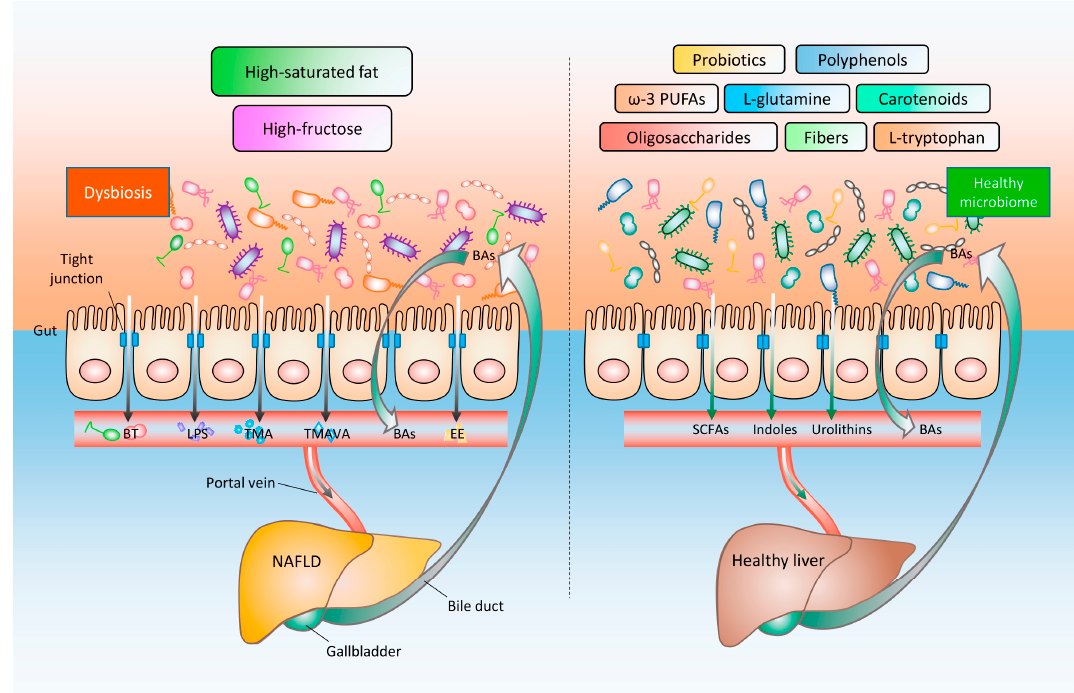
Figure 1. Non-alcoholic fatty liver disease (NAFLD) induced by unbalanced diet and its nutritional improvement strategies based on the gut–liver axis. Long-term high-saturated fat or high-fructose diet leads to an imbalanced intestinal flora, which in turn elicits an impaired gut barrier function and increased permeability, followed by bacterial translocation (BT), and additional bacterial components and metabolites (e.g., lipopolysaccharides (LPS), trimethylamine (TMA), N,N,N-trimethyl-5-aminovaleric acid (TMAVA), and endogenous ethanol (EE)) entering into the liver through the portal vein. NAFLD patients exhibit abnormal bile acids (BAs) metabolism and its related signaling pathways. These factors together accelerate the occurrence and progression of NAFLD. By contrast, an appropriate consumption of probiotics, functional oligosaccharides, dietary fibers, ω -3 polyunsaturated fatty acids ( ω -3 PUFAs), functional amino acids (L-tryptophan and L-glutamine), carotenoids, and polyphenols, contributes (1) to the maintenance of the homeostasis of the intestinal flora and BAs, (2) to the enhancement of the intestinal barrier integrity, and (3) to the production of salutary metabolites (e.g., short chain fatty acids (SCFAs), indoles, and urolithins), thereby supporting a healthy